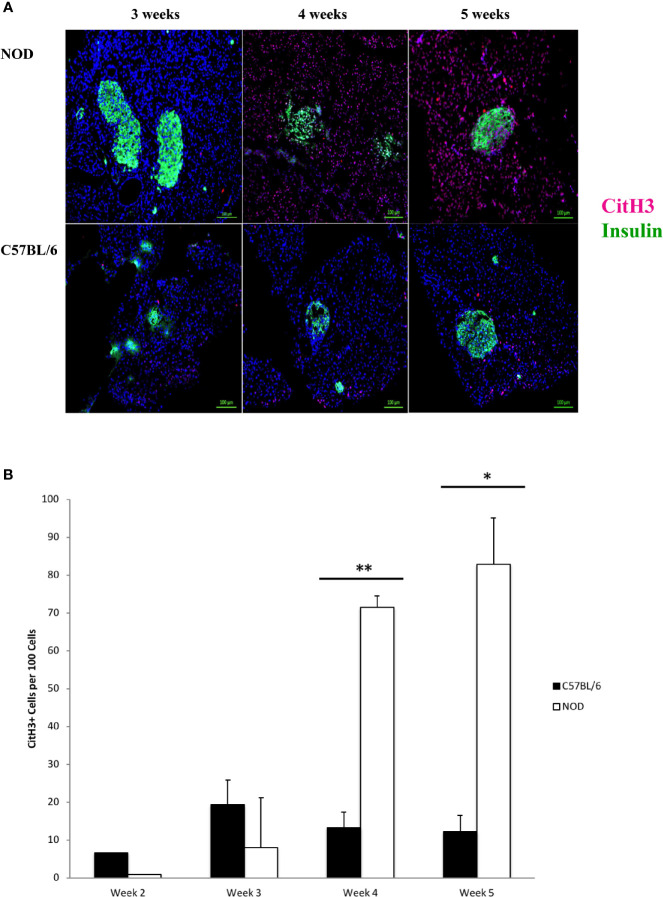
Generalized distribution of citrullinated histone H3 in mostly the non-endocrine tissue of NOD, but not C57BL/6 pancreata beginning at 4 weeks of age. (A) Citrullinated histone H3 is considered to be an informative marker of neutrophil extracellular trap formation. Serial sections from formalin-fixed paraffin-embedded pancreata of 3-5 week old female NOD and C57BL/6 mice were stained with fluorochrome-tagged antibodies to insulin and citrullinated histone H3 (CitH3). Immunofluorescence shown is representative of outcomes observed in at least three individual mice of each strain. Bar at the bottom of each image represents the length of 100 μm. (B) Quantification of CitH3+ signals in serial sections from post-natal pancreas of NOD female and C57BL/6 female mice. The number of CitH3+ events and DAPI nuclear stain were determined using the QuPath Software version 0.1.2. Means of positive signals, following autofluorescence removal, were determined among three to five slides per pancreas per antibody target and presented graphically as the number of marker-positive cells per 100 total cells. The number of CitH3+ events is elevated in NOD, reaching significance at 4 and 5 weeks of age. Statistical significance was determined by a student’s t-test at individual weeks of age with a of p < 0.05 designated by * and p < 0.01 designated by **.